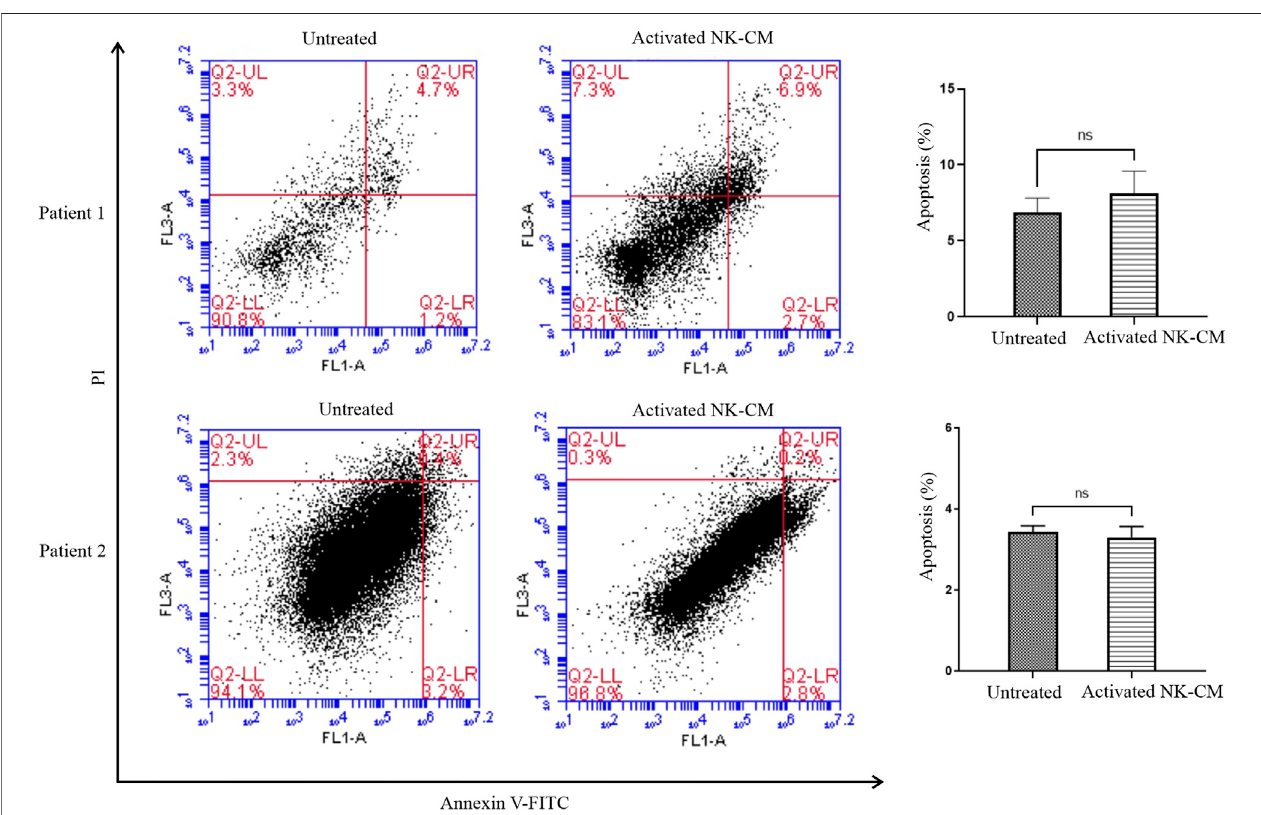
FIGURE 6 | Annexin V-FITC/propidium iodide (PI) double staining assay. Colon tumor organoids were harvested after 48 h treatment with IL-2-activated NK-CM, then were incubated with Annexin V FITC for 20 min and dissociated. PI was added just before the fl ow cytometry analysis. The percentage of Annexin V-FITC-positive/ PI-negative and Annexin V-FITC-positive/PI-positive cells are also shown. Data presented as means ± standard error (M± SE). Statistical signi fi cance was determined using an unpaired t -test with * p < 0.05.